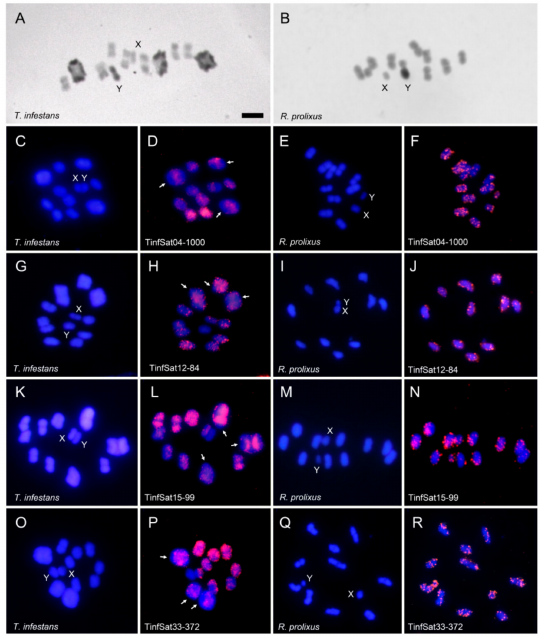
Figure 3. C-banding and chromosome location of the satDNA families in male meiotic chromosomes (first meiotic metaphases) of Triatoma infestans and Rhodnius prolixus . C-banding in T. infestans ( A ) and R. prolixus ( B ); ( C – R ) First and third columns DAPI staining (blue) and second and forth columns FISH with the different satDNA probes (pink). Arrows in D, H, L and P indicate some of the heterochromatic regions lacking hybridization signals on the three largest bivalents of T. infestans . Bar = 5 µ